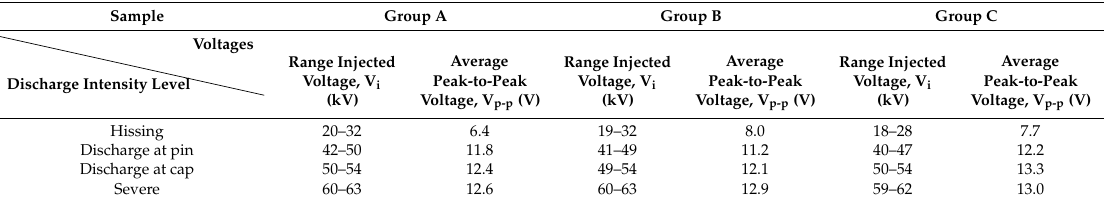
Table 9. Injected voltage and average peak-to-peak voltages of the UV signals for dry insulators conditions with light contamination level.